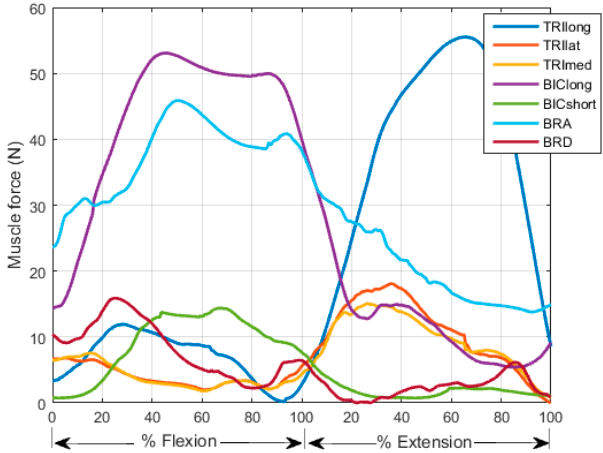
Figure 9. Estimation of individual muscle forces during elbow flexion and extension of one subject ( Th = 0.8). BIClong and BRA are the main action muscles in the flexion phase. TRIlong is the main action muscle in the extension phase.